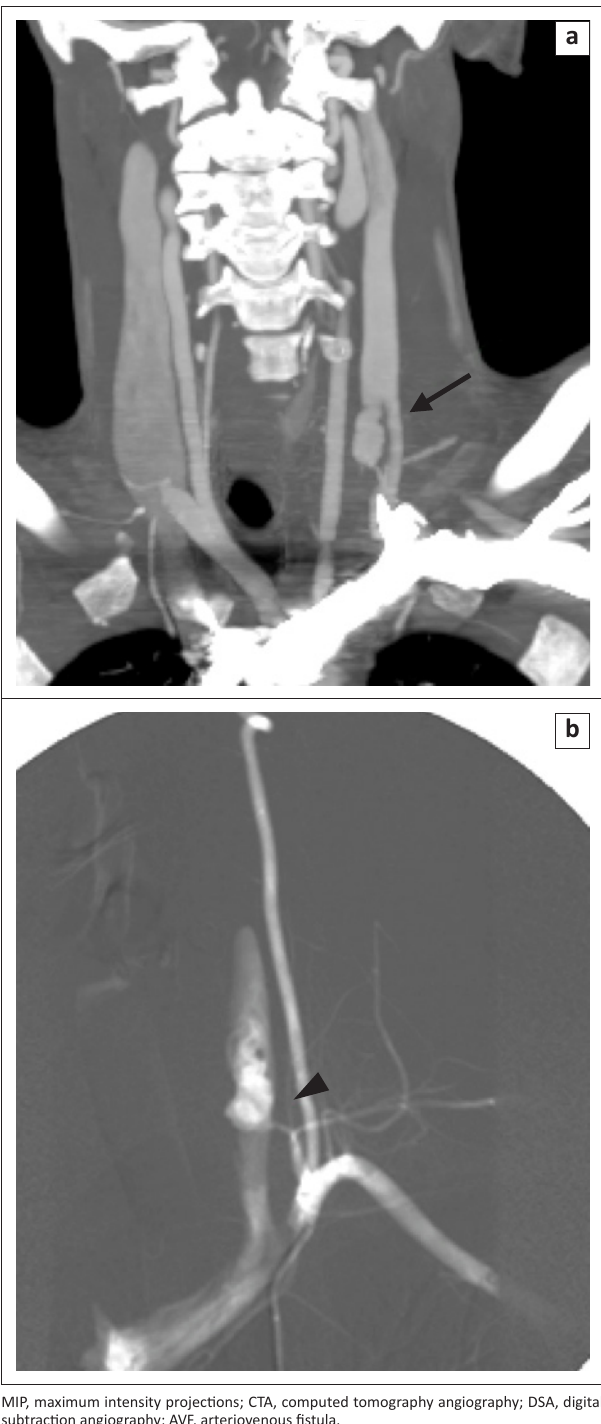
FIGURE 4: (a) The coronal reformatted MIP CTA shows an apparent injury to the left internal jugular vein (arrow). On the DSA (b), an AVF from the inferior thyroid artery to the internal jugular vein is demonstrated (arrowhead).